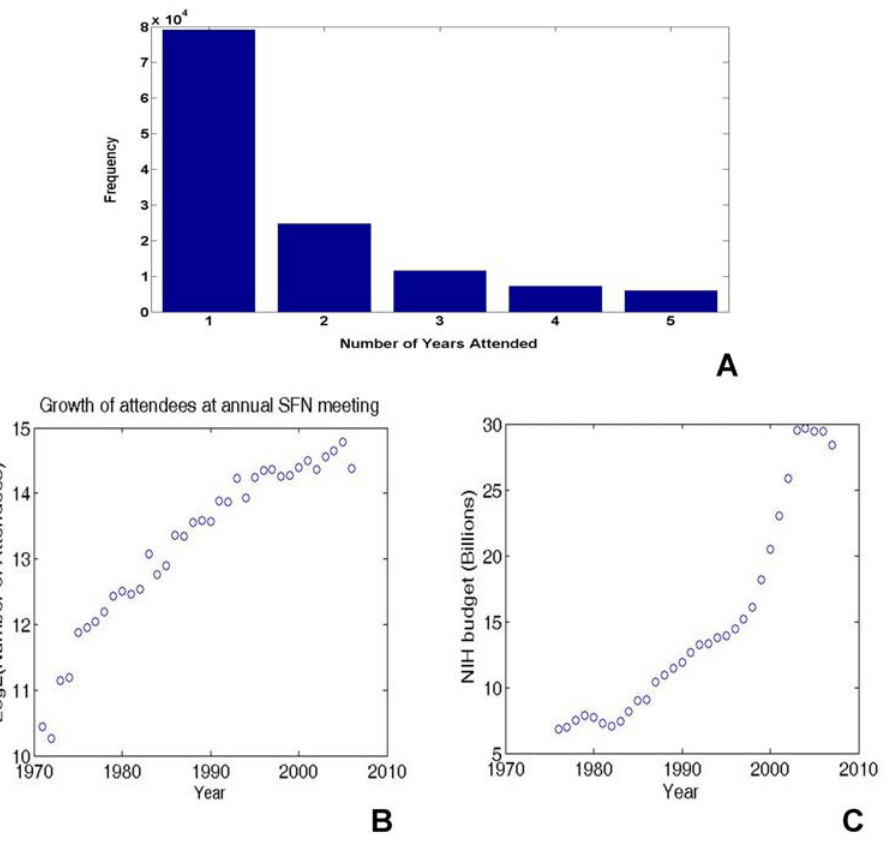
Figure 5. (A) Histograms of the number of years in which authors are represented. (B) Growth of attendees at annual SFN meeting from 1971 to 2006 (in base 2 logarithm). (C) Growth of NIH funding from 1976 to 2006.